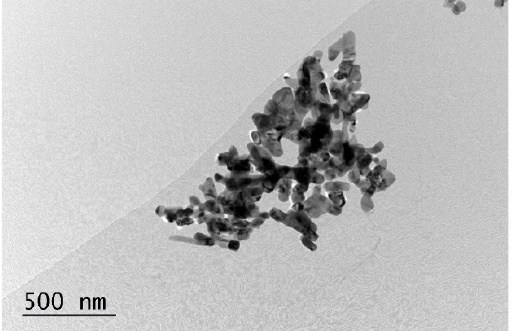
Figure 1. TEM image of CuO nanoparticles in water (0.02 g/L, pH 7.5).